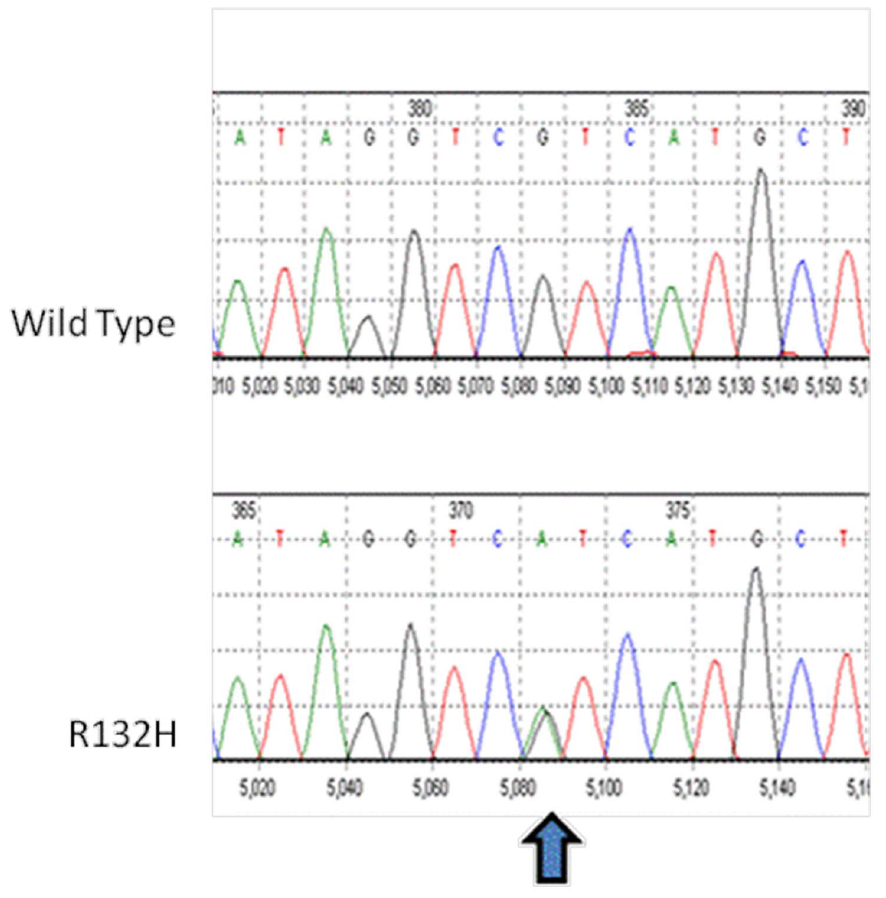
Figure 1. Nucleotide sequence analysis. Nucleotide sequence analysis of IDH1 showing mutation at codon 132 of IDH1 gene. Arrows indicate the position of the different nucleotide substitutions.